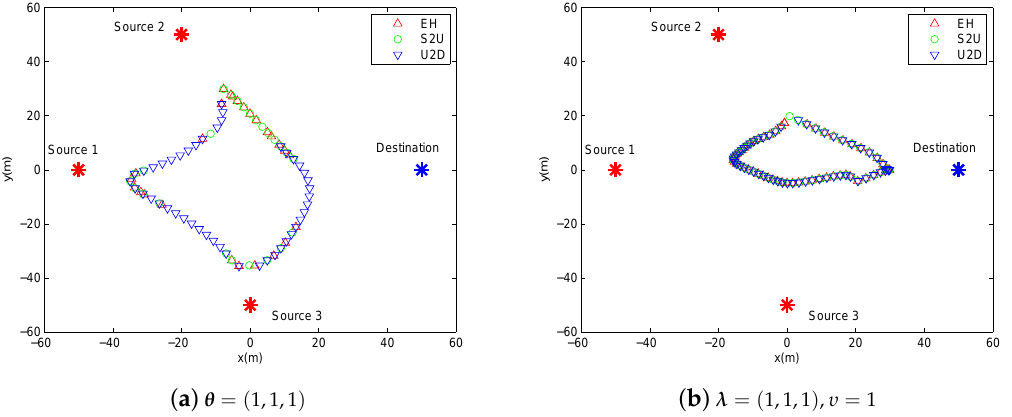
Figure 5. The illustration of scheduling in each slot for period T = 60